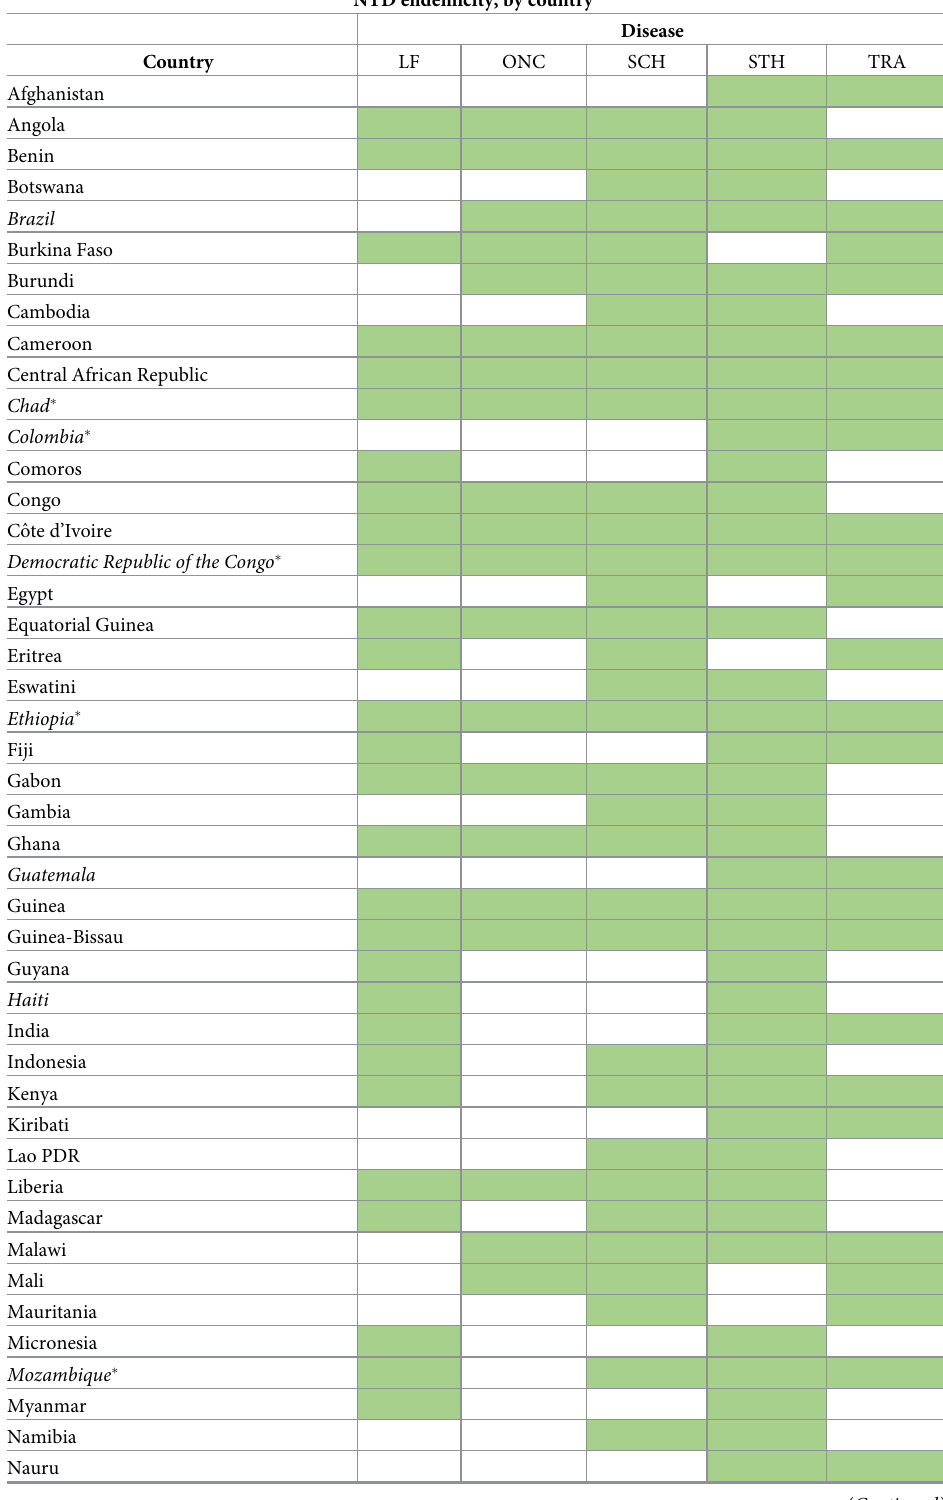
Table 1. Reported co-endemicity of 5 NTDs, by